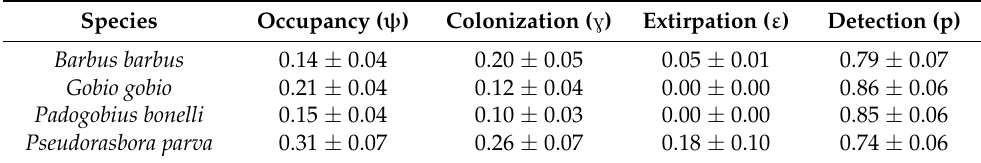
Table 2. Overall occupancy ( ψ ), colonization ( G ), extirpation ( ε ) and detection (p) probabilities ( ± SE) for Barbus barbus , Gobio gobio , Padogobius bonelli and Pseudorasbora parva .